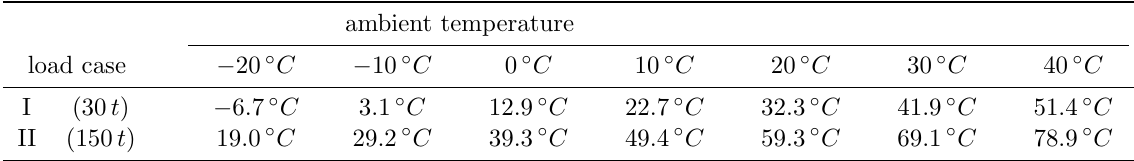
Table 2: Thermic gearbox model - results